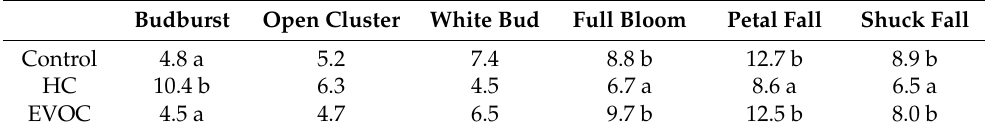
Table 4. Effect of hydrogen cyanamide (HC) and emulsified vegetable oil compound (EVOC) on